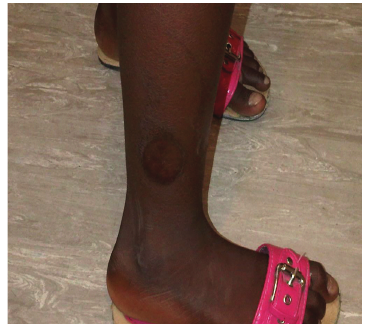
Figure 2: The exit wound on the right leg.